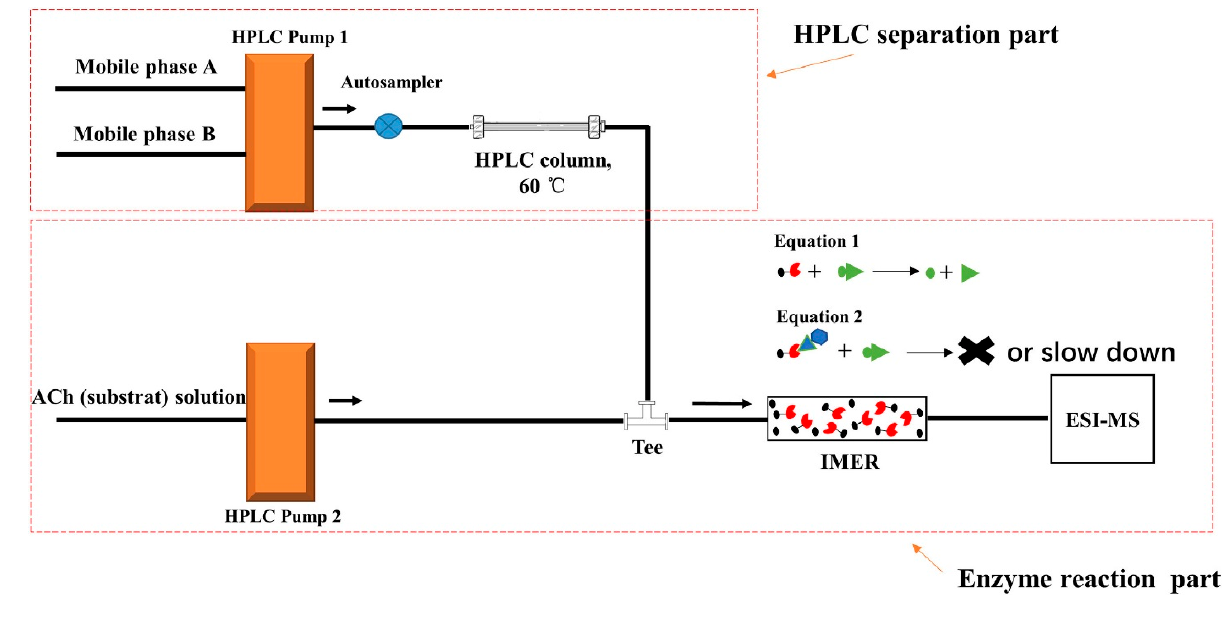
Figure 4. HPLC-IMER-MS bioanalytical device. Immobilized AChE (( ) continuously converts ACh ( ) into Cho ( ) when no AChE inhibitors are eluted from the HPLC column (Equation (1)); when AChE inhibitors ( ) are present in the eluate, they bind to the immobilized AChE, resulting in an increase in remaining ACh and a decrease in detected Cho (Equation (2)). Reprinted with permission from Ref. [25]. Copyright 2017 Elsevier.